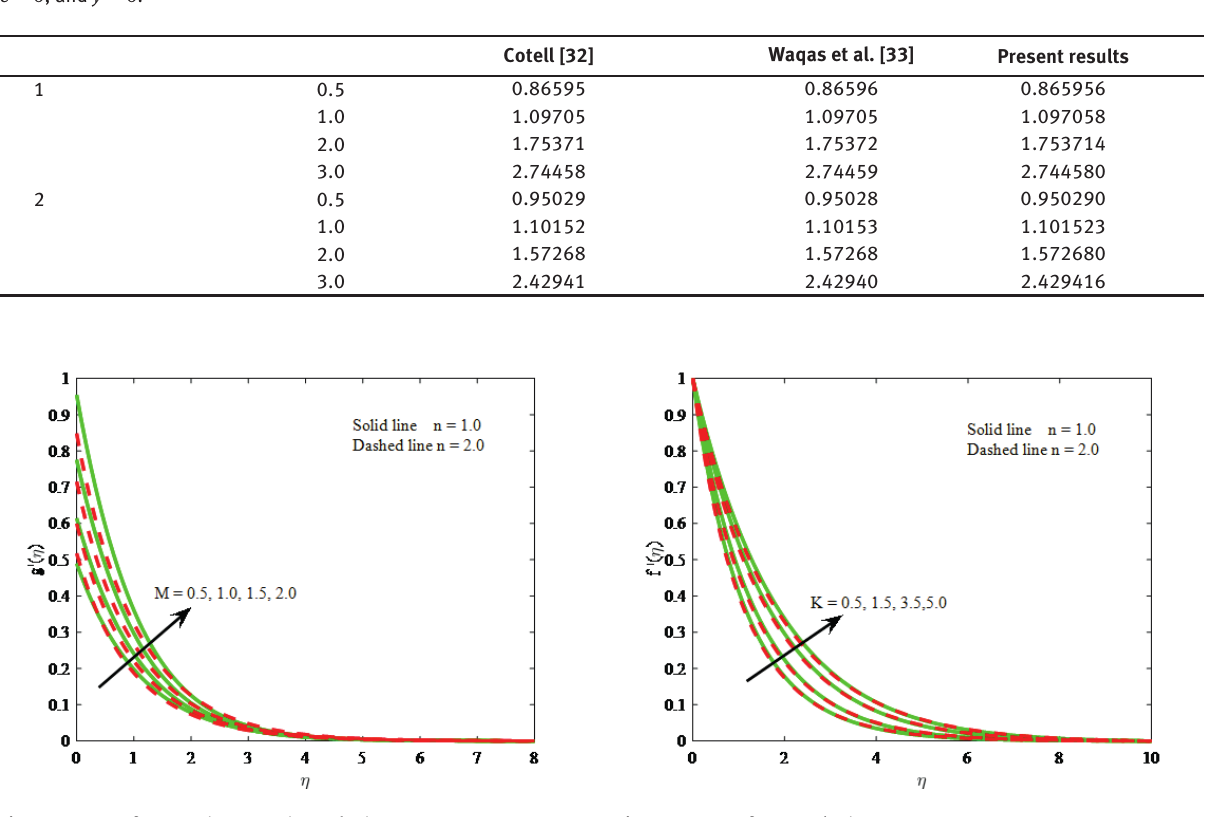
Fig. 5: Impact of K on velocity.